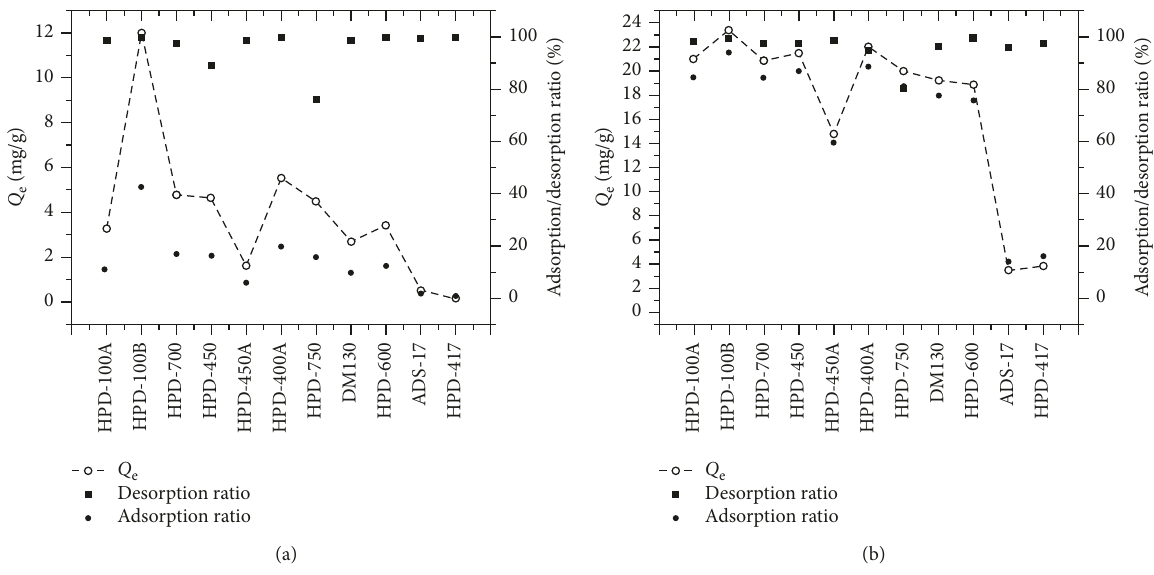
Figure 2: Adsorption capacity ( Q e ) and adsorption and desorption ratio of (a) syringoside and (b) oleuropein on different resins.